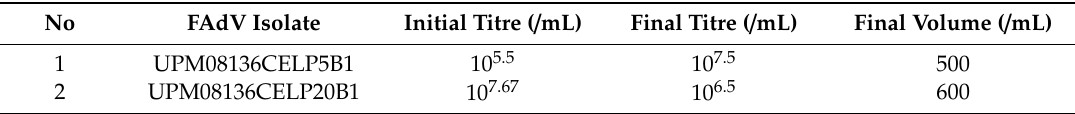
Table 4. Final volume and virus titer (TCID 50 ) of FAdV propagated in CEL cells adapted on Cytodex ™ 1 Microcarriers in a Stirred Tank Bioreactor.